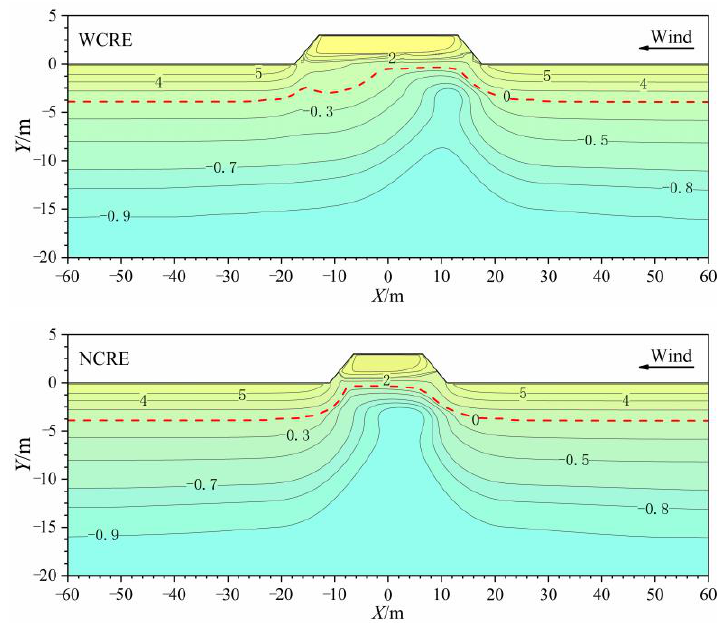
Figure 11. Distribution of the soil temperatures beneath the WCRE and the NCRE on 15 October in the 50th year after the embankment construction.